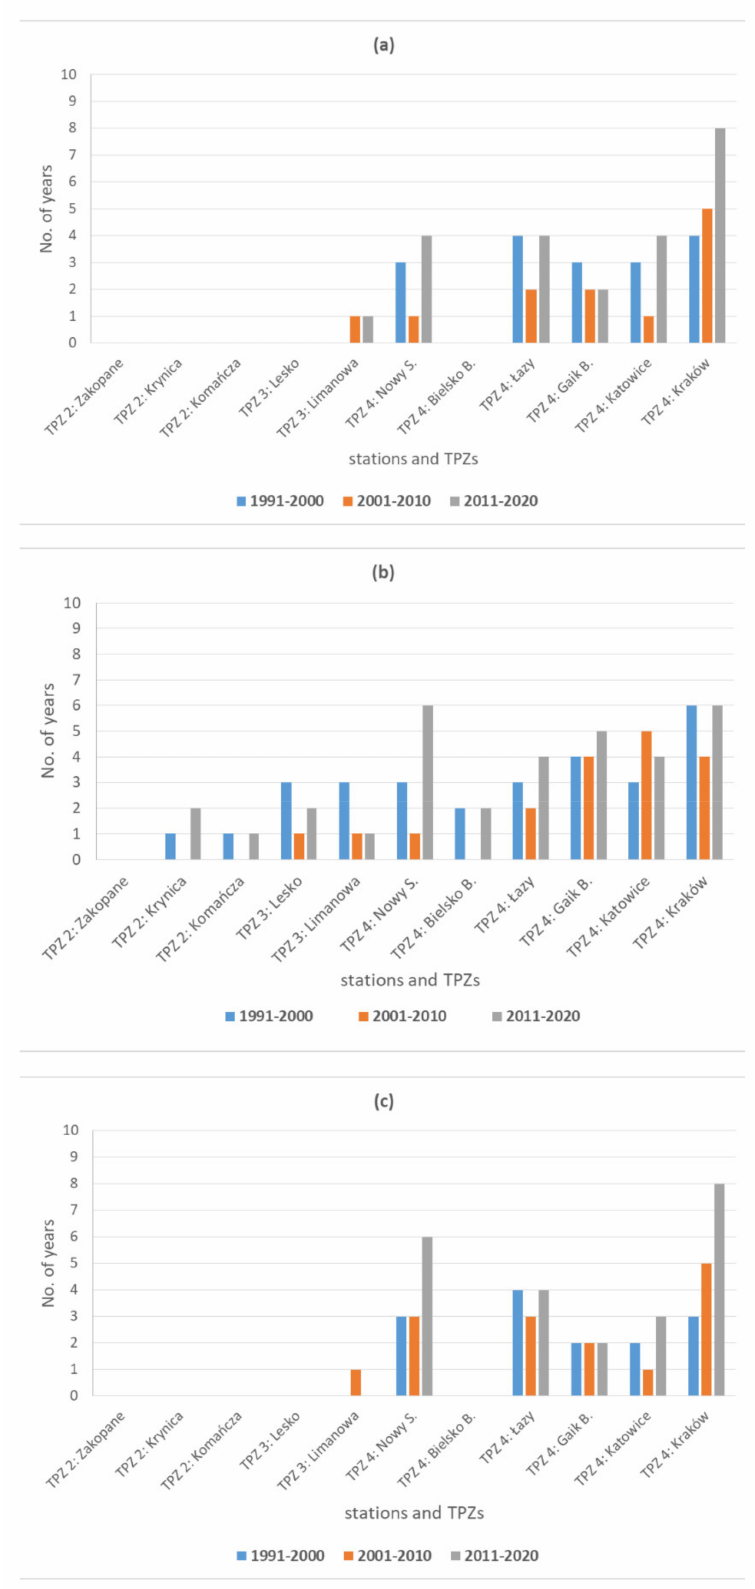
Figure 9. The number of years in specific decades when forest drought conditions unfavorable for beech occurred at the stations studied: ( a ) EQ > 30; ( b ) FAI > 4.75; ( c ) AI < 35. Stations are ordered following the concept of TPZ explained in Section